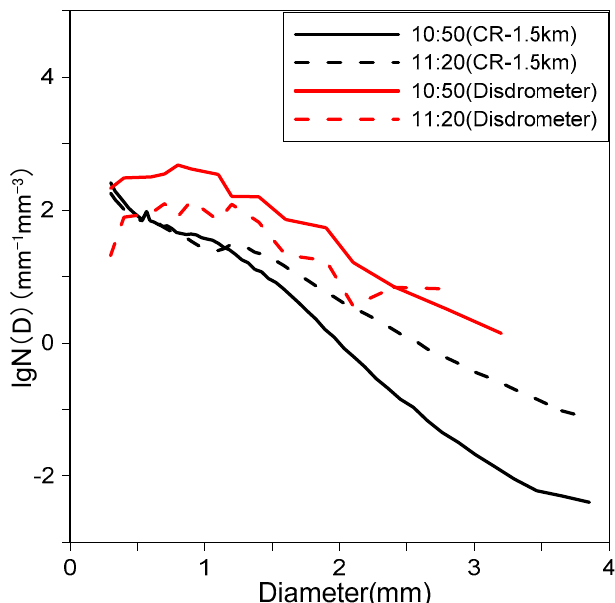
Figure 5. Comparison of retrieved DSD at 1.5 km and disdrometer-obtained DSD during segments B (convective clouds), C (transition clouds), and D (stratified clouds) (unit: mm − 1 m − 3 ).